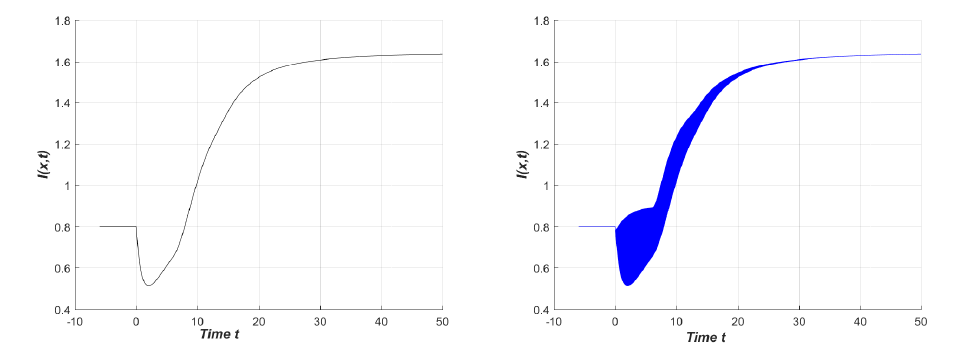
Figure 5. Comparison projection of compartment I when D = 0 and D =